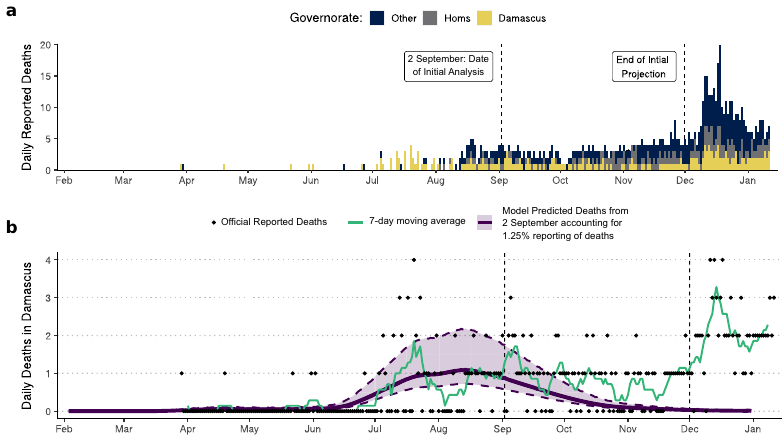
Fig. 4 Predictive performance of second wave dynamics in Damascus. In ( a ) the of fi cial reported COVID-19 deaths in Syria are shown, with deaths in Damascus (gold) and Homs (grey) governorates highlighted indicating the shifting burden COVID-19 has placed on regions outside of Damascus. In ( b ) the performance of model projections made on 2 September (purple, median and 95% CI in shaded region) are shown compared against of fi cially reported COVID-19 deaths (black points) and the weekly rolling mean (green). Model predictions correctly suggested a decrease in COVID-19 deaths in Damascus after the peak during the Summer, however, they failed to predict an increase in reported COVID-19 deaths towards the end of